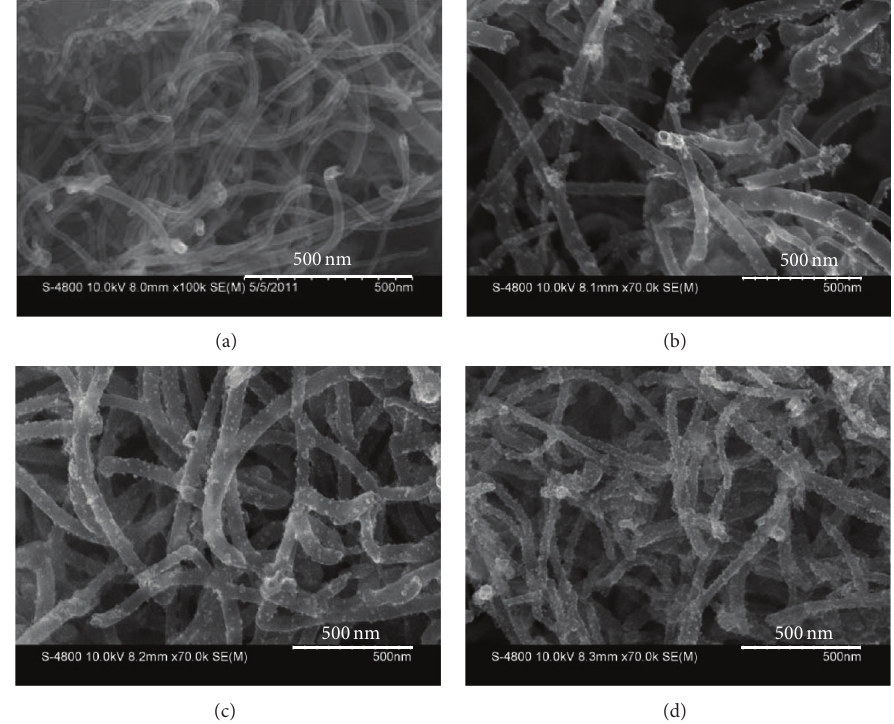
Figure 2: SEM images of bare CNx (a), TiO 2 -CNx composites with different weight ratio of TiO 2 over CNx 5% (b), 10% (c), and 20% (d).